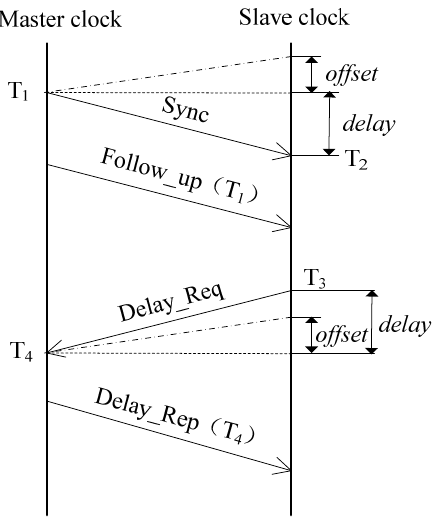
Figure 2. PTP time synchronization message interaction process.